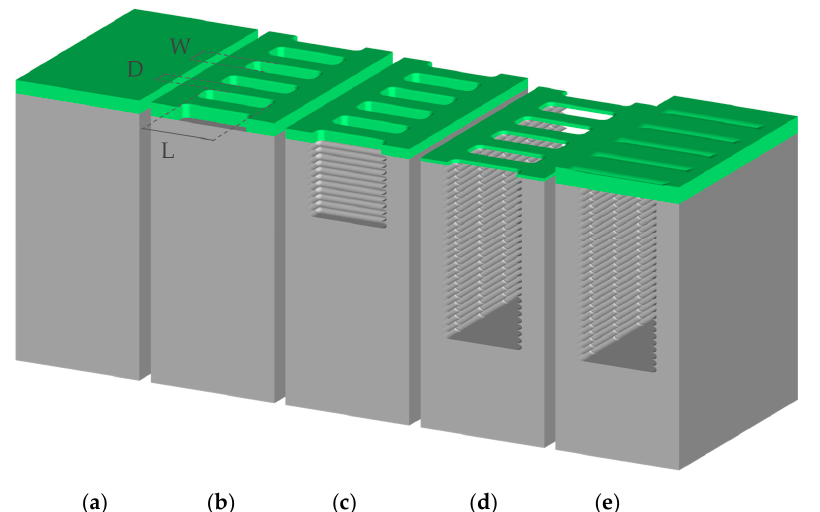
Figure 1. HAR, embedded microchannels fabrication stages: ( a ) deposition of the silicon dioxide; ( b ) patterning the SiO 2 hard etch mask; ( c , d ) simultaneous etch of trenches in the silicon and